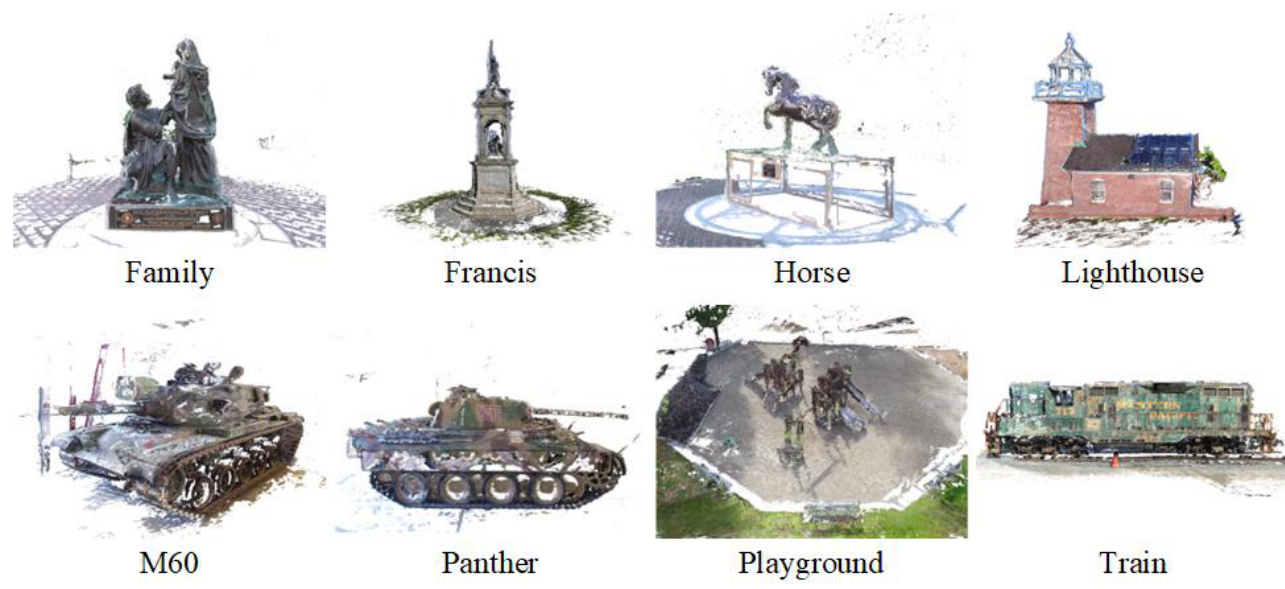
Figure 12. Reconstruction result on Tanks and Temples.